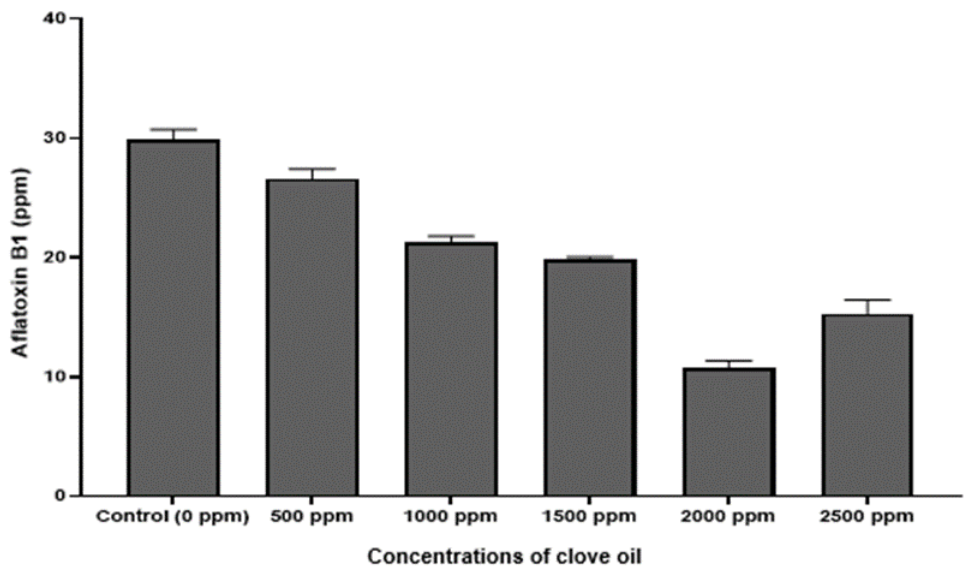
Figure 7. Column plot of the relation between the clove oil used versus residual aflatoxin (AFB1) after exposure of A. flavus mycelium to clove oil at different concentrations (ppm).